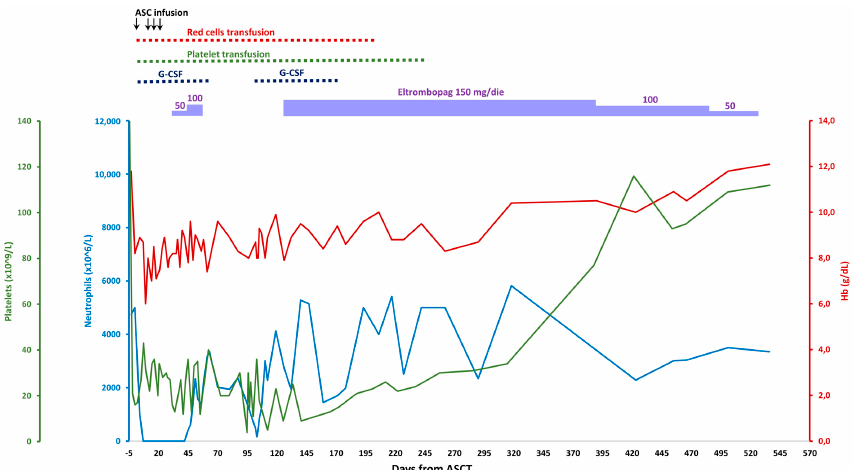
Figure 1. Hemoglobin (red line), neutrophils (blue line) and platelets (green line) trends from ASCT to eltrombopag discontinuation. ASCT, autologous stem cells transplant; G-CSF, granulocyte colony-stimulating factor.